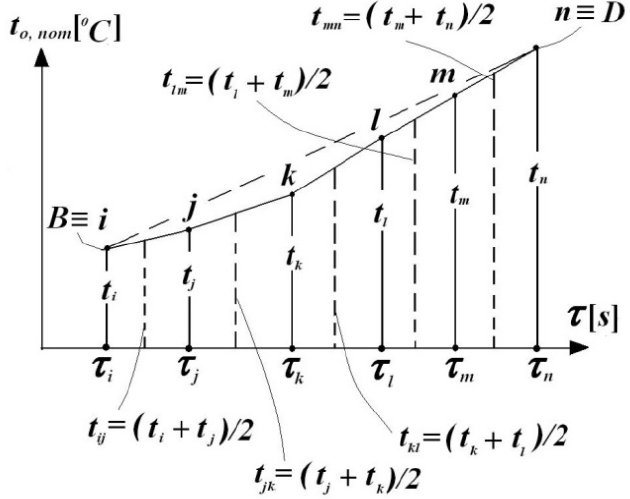
Figure 3. The particularity of the heating system’s thermo-regulation [56,64]. The invested heat Q total ( J ) will be the difference of the previous ones, i.e.,